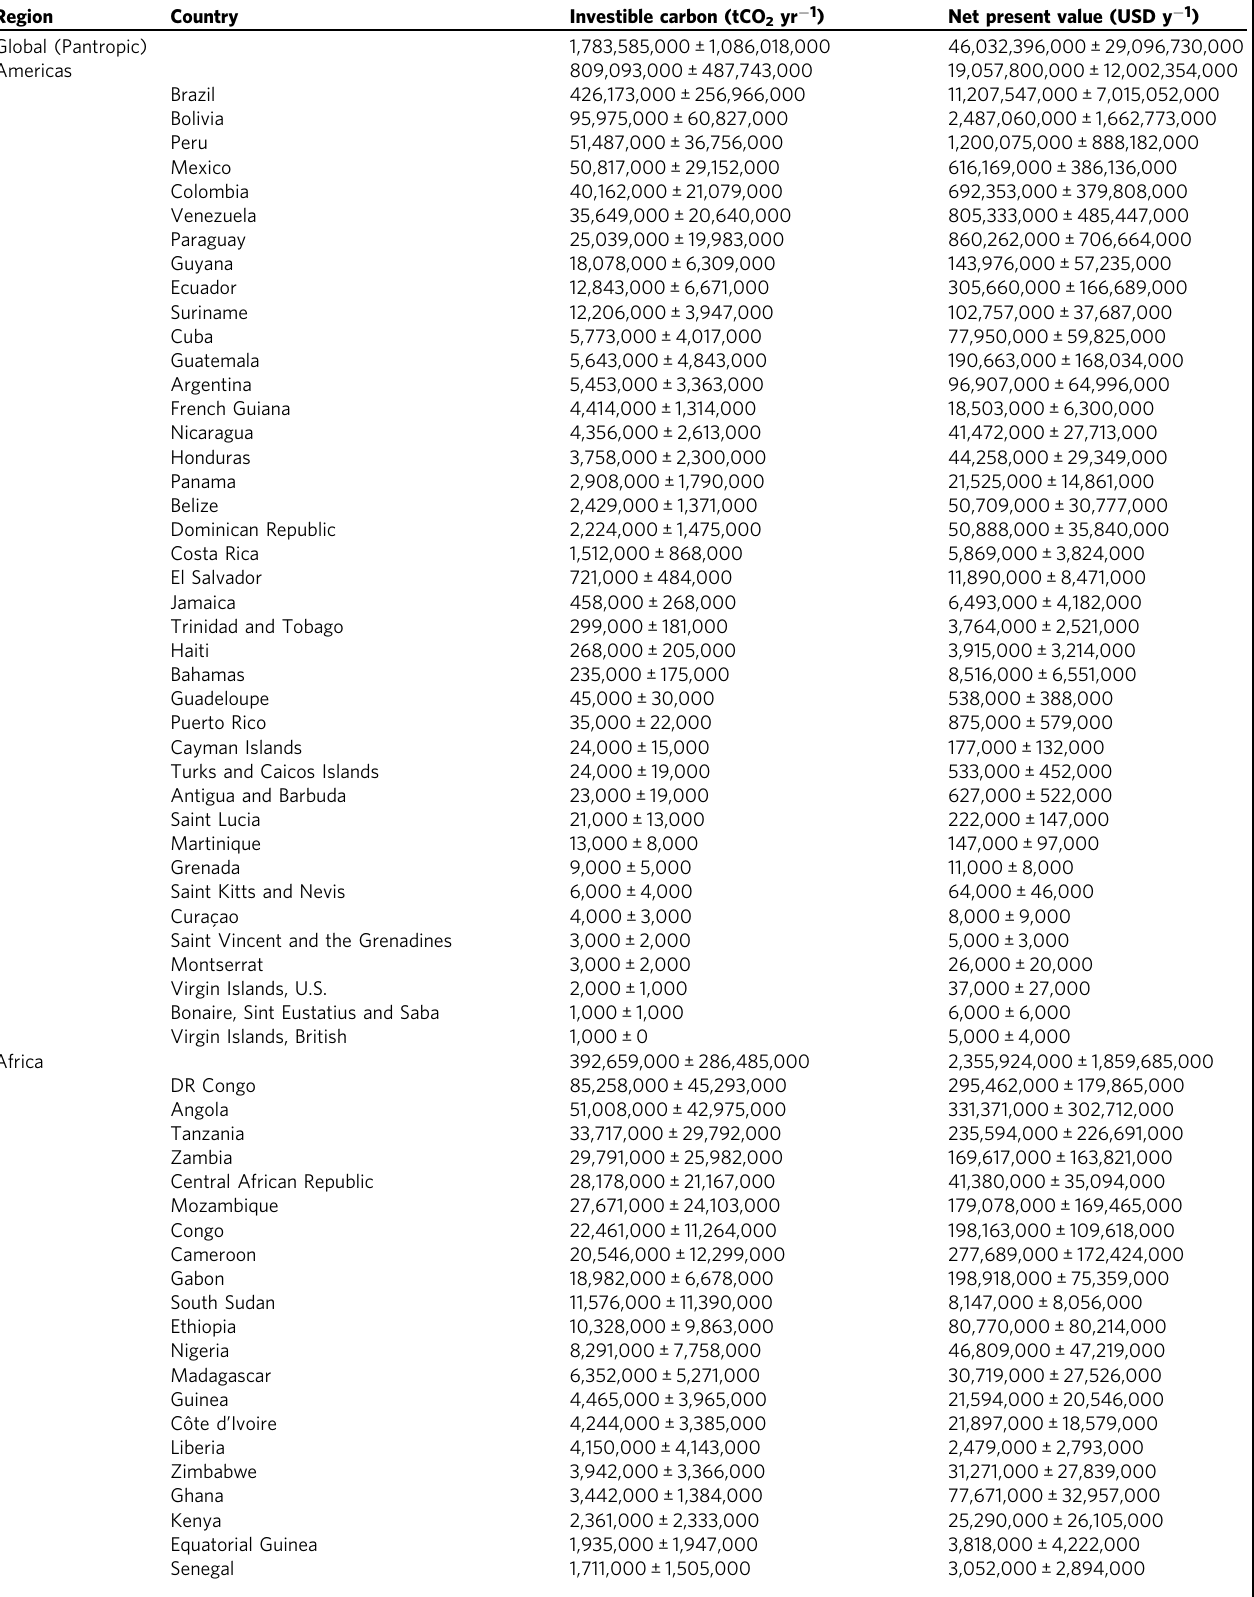
Table 1 Global, regional, and country-level estimates of investible carbon and return-on-investment (based on net present